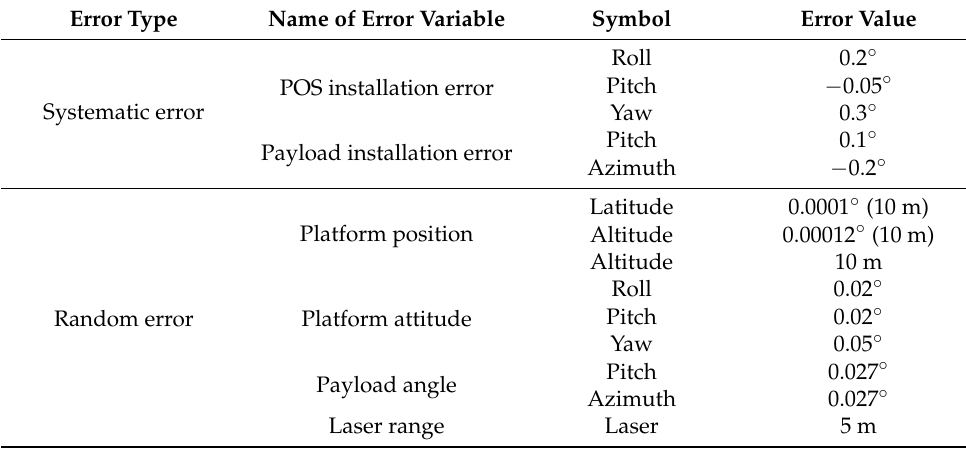
Table 1. Systematic error and random measurement error in the